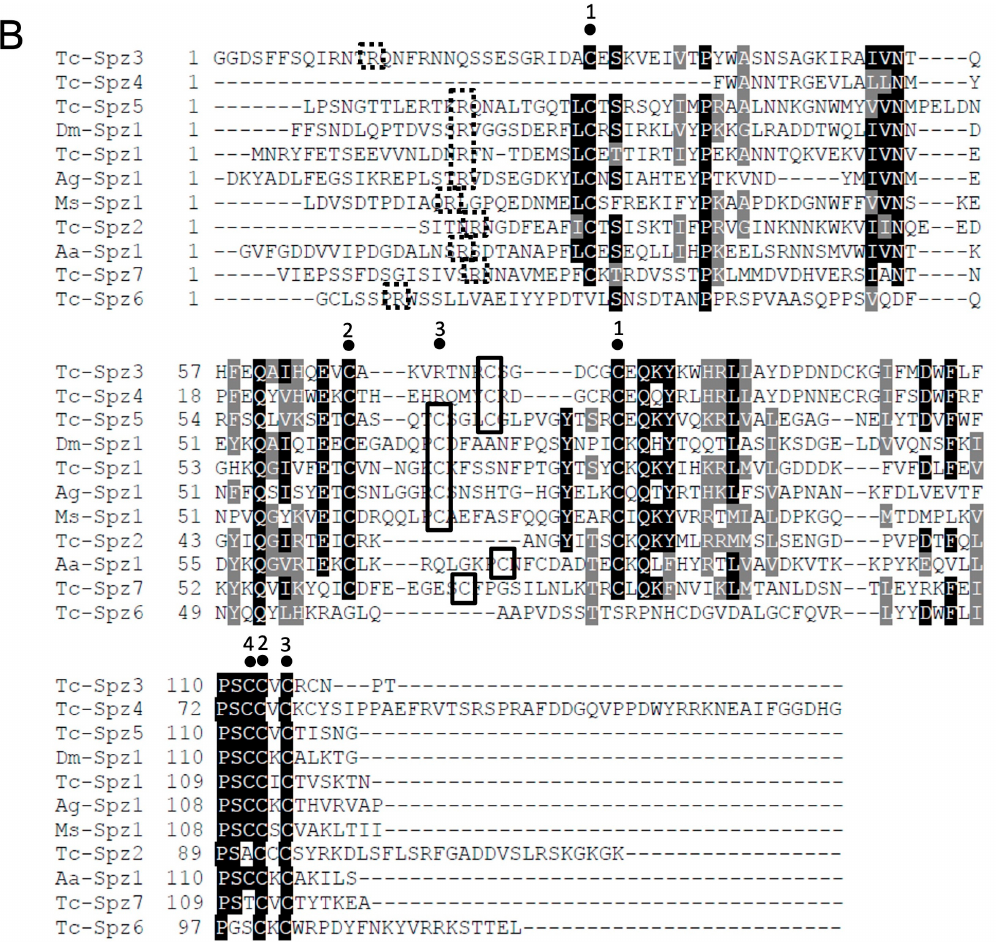
Figure 8. Phylogenetic analysis of spz protein and sequence alignments of spz C terminal sequences. ( A ) A phylogenetic tree was constructed using spz protein sequences of T. castaneum (Tc-spz), D. melanogaster (Dm- spz), A. gambiae (Ag-spz), A. aegypti (Aa-spz), and M. sexta (Ms-spz) (the accession IDs are listed in Supplemental Table S1 ). Numbers on branches indicate bootstrap values. ( B ) Sequence alignment results of 120 amino acid sequences from spz C-terminal (Supplemental Data S1) are shown using BoxShade. White letters in black and gray indicate completely matched or similar residues among the sequences, respectively. Dashed squares indicate proteolytic cleavage sites of arginine residues. The numbers 1, 2, and 3 (bold boxes) above cysteine residues indicate the residues predicted to form the disulfide bond essential for cysteine binding, whereas